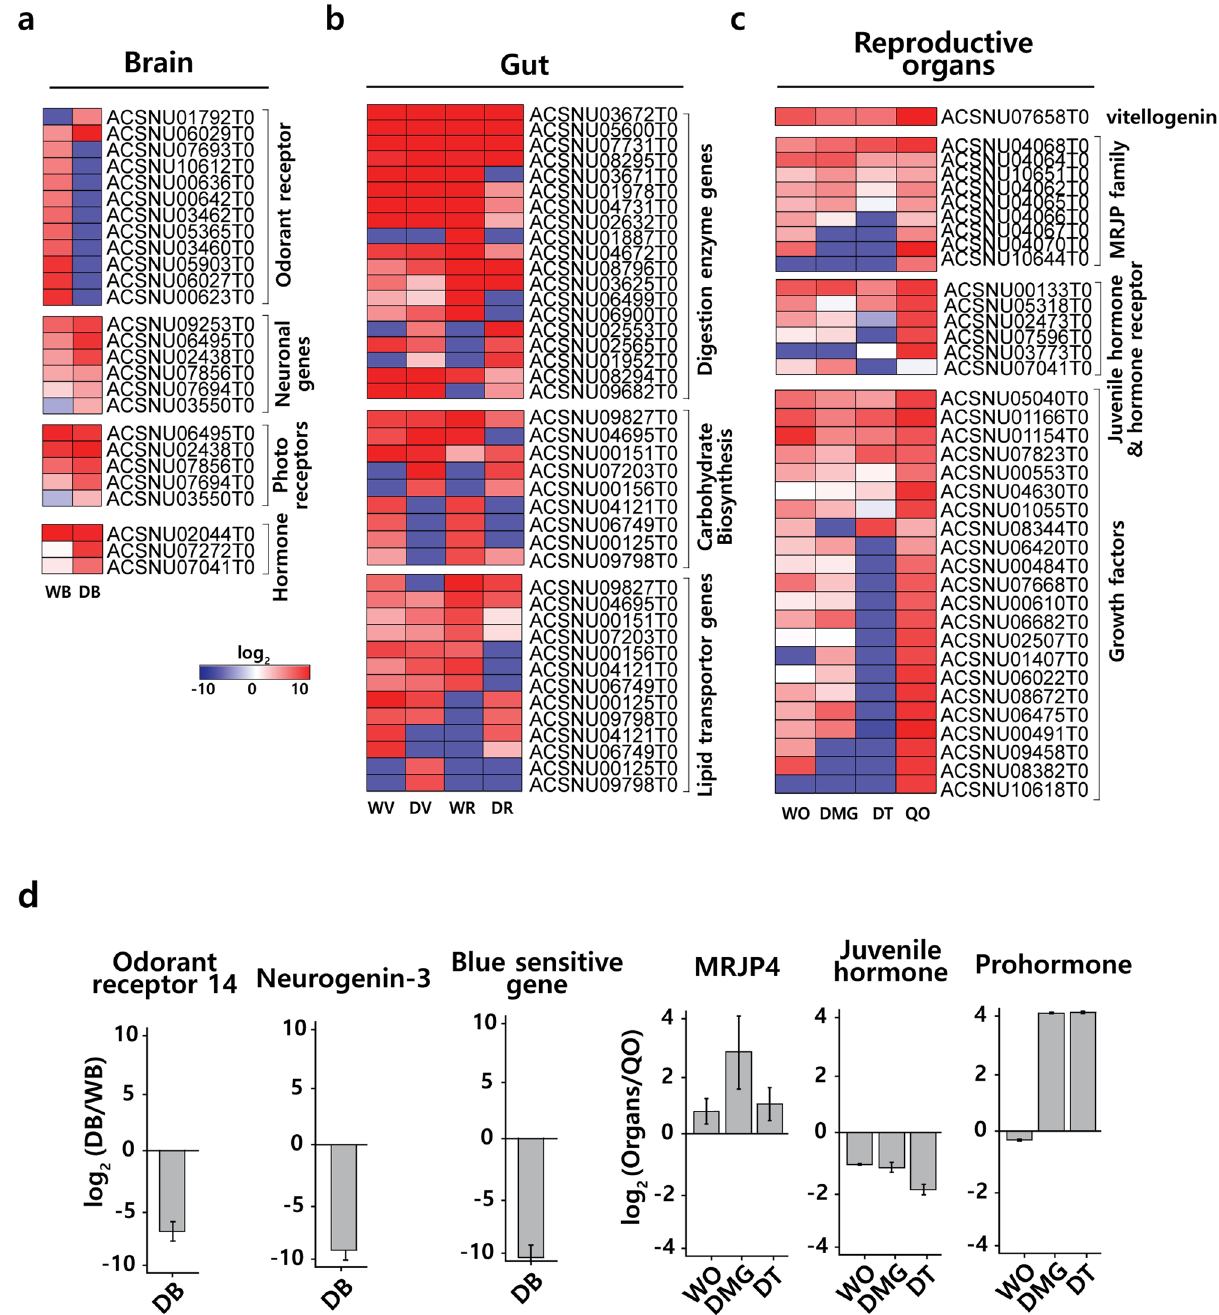
Figure 3. Heat map of transcripts. ( a ) Expression of 26 selected genes among worker and drone brains. 12 genes were related to the odorant receptor family. Six genes were neuronal genes. Five genes were related to vision. Three genes were related to hormone synthesis or hormone peptides. ( b ) Expression of 41 selected genes among worker and drone guts. 19 genes were related the digestive enzyme. Nine genes were related to carbohydrate synthesis. 13 genes were related to lipids. ( c ) Expression of 37 selected genes among worker, drone and queen of reproductive organs. Nine of the major royal jelly protein (MRJP) family. Six genes were related to the juvenile hormone or hormone receptor. 22 genes were related to the growth factor. Each selected gene presented a log 2 fold change. ( d ) Relative expression of brain related genes and reproductive organ related genes exhibiting a significant change. See Supplementary Table S5 for primers. WB worker brain, WV worker ventriculus, WR worker rectum, WO worker ovary, WVG worker venom gland, DB drone brain, DV drone ventriculus (midgut), DR drone rectum, DMG drone mucus gland, DT drone testis, QO queen